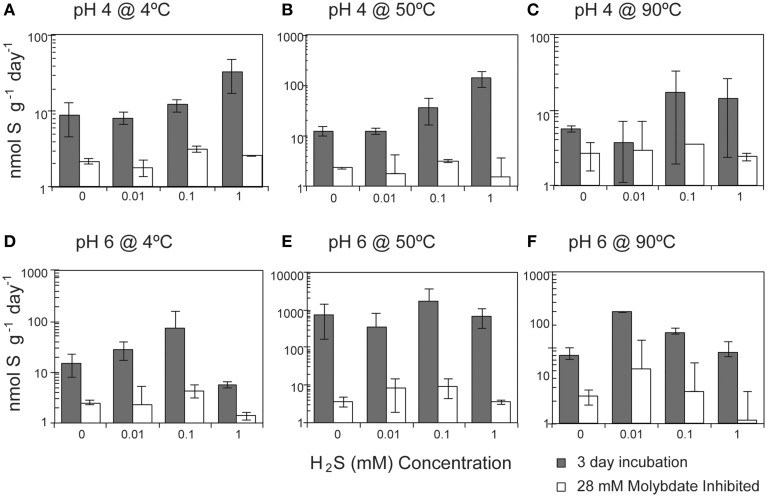
Effect of sulfide concentration on sulfate reduction rates. The crushed flange from the Grotto hydrothermal deposits were incubated for 3 days () in media of (A) pH 4 at 4°C, (B) pH 4 at 50°C, (C) pH 4 at 90°C, (D) pH 6 at 4°C, (E) pH 6 at 50°C, and (F) pH 6 at 90°C. 28 mM molybdate amended samples were incubated under all conditions (□) as controls. Error bars represent 1 standard deviation. Note different scales for (A,C).